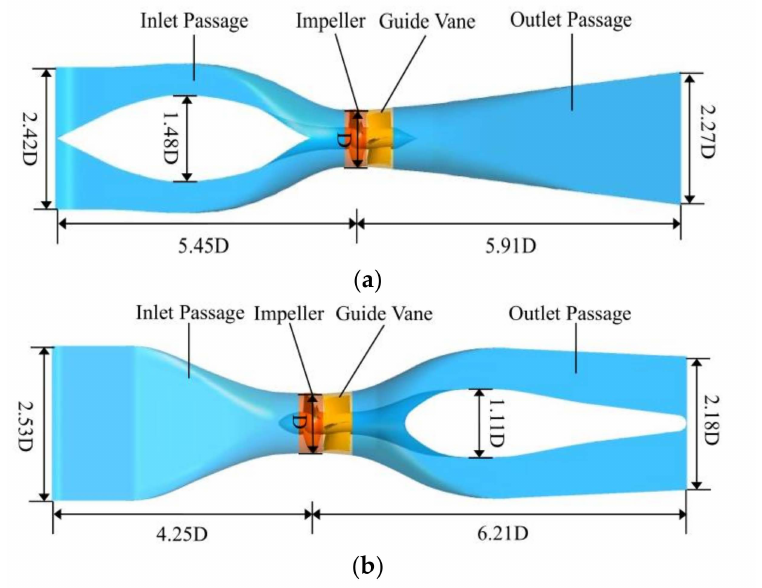
Figure 1. 3D model of pump device: ( a ) shaft front-positioned tubular pump device; ( b ) shaft rear-positioned tubular pump device. Table 1. The main design parameters of pump devices.